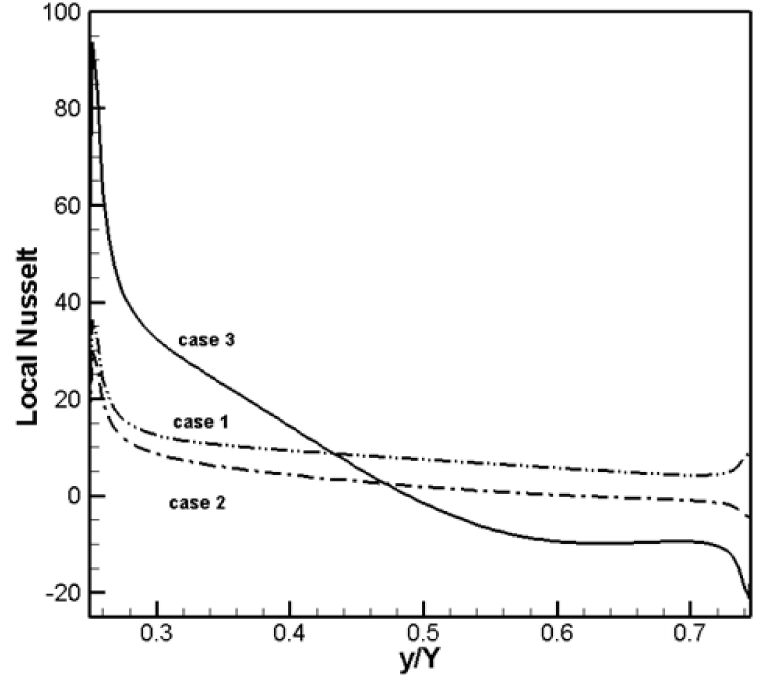
Figure 9. Variation of left local Nusselt number along the central partially heated left boundary (Cu-water nanofluid) for different left wall BCs (Boundary Conditions) (case 1: Dirichlet constant BC, case 2: linear BC, case 3: sinusoidal BC) at Ra = 10 5 and volume fraction φ =